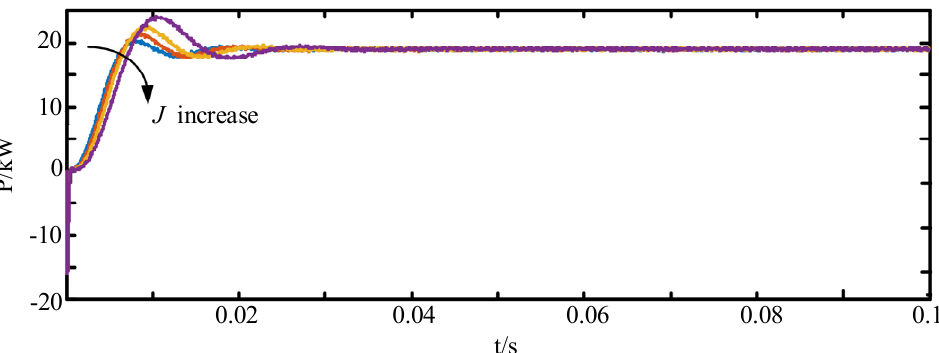
Figure 11. Simulation of rotational inertia affecting system’s active output performance.